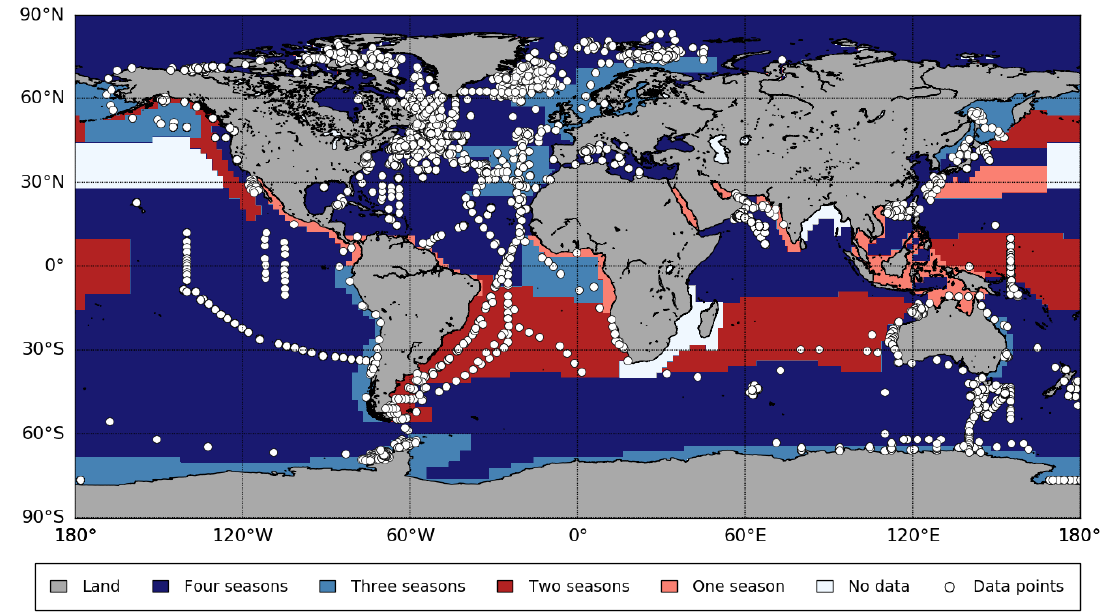
Figure 1. Sample locations for photosynthesis versus irradiance (P-I) experiments obtained from databases and literature with seasonal coverage in each biogeographic province as defined by Longhurst (2007). A total of 8676 P-I experiments were used in the present study, covering 53 biogeographic provinces and 96.6% of the world’s ocean. High seasonal data coverage was obtained for 37 provinces (3–4 seasons, 79.9% coverage).